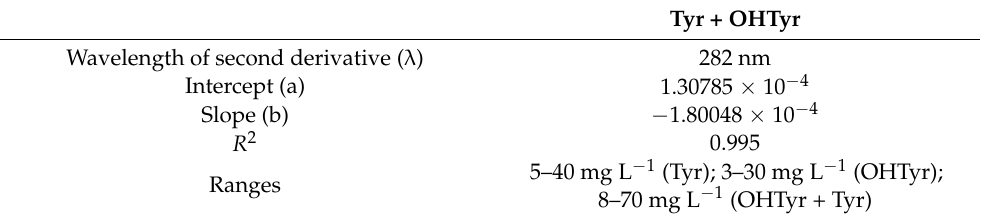
Table 4. Parameters of the calibration curve of OHTyr + Tyr in NADES.